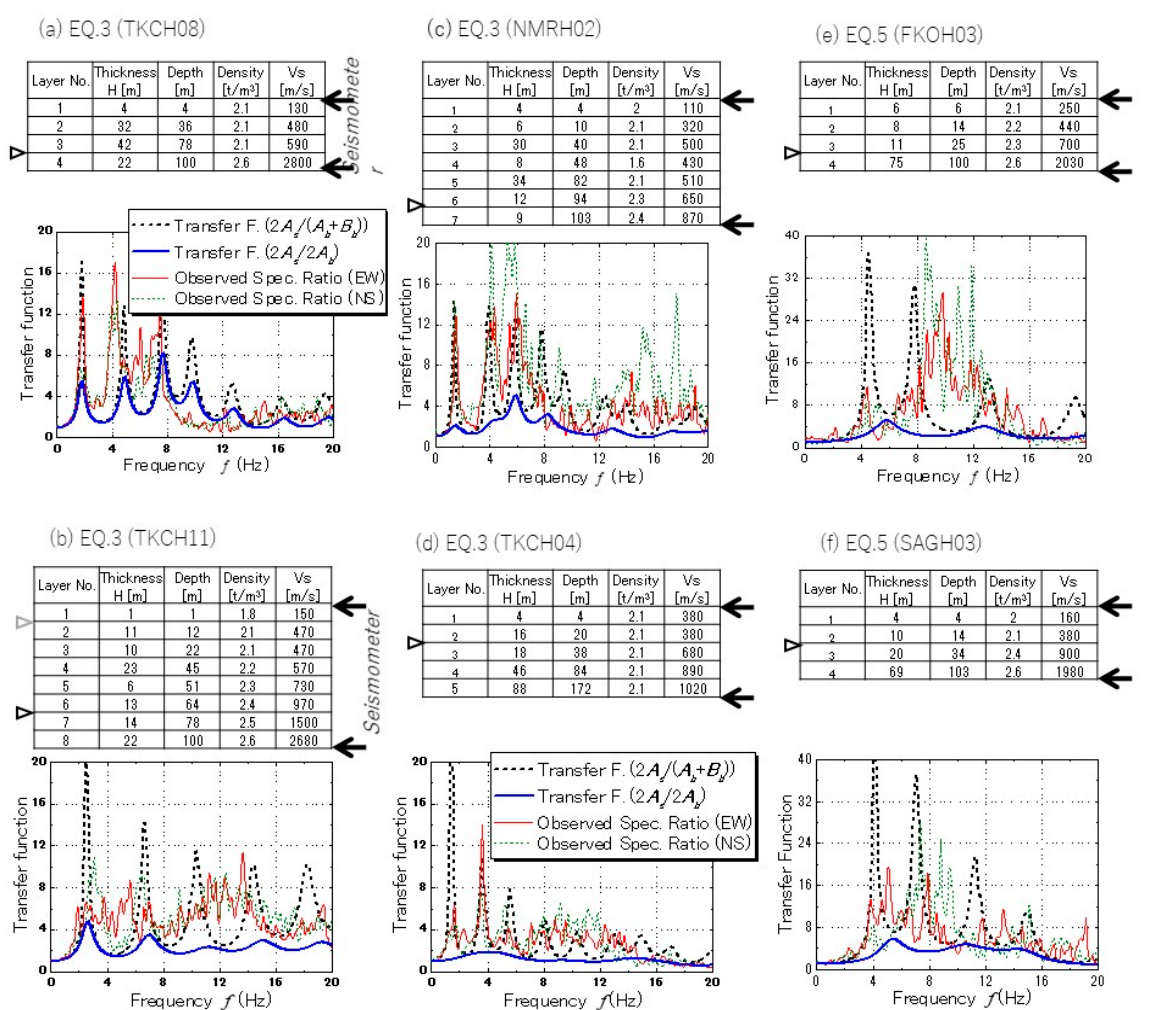
Figure 4. Typical transfer functions (2 A s /( A b + B b )) versus 2 A s /2 A b compared with observed spectrum ratios at 6 sites ( a – f ). Table 1. 8 strong earthquakes EQ1~EQ8 recorded by KiK-net vertical arrays and utilized in this paper with pertinent values. EQ